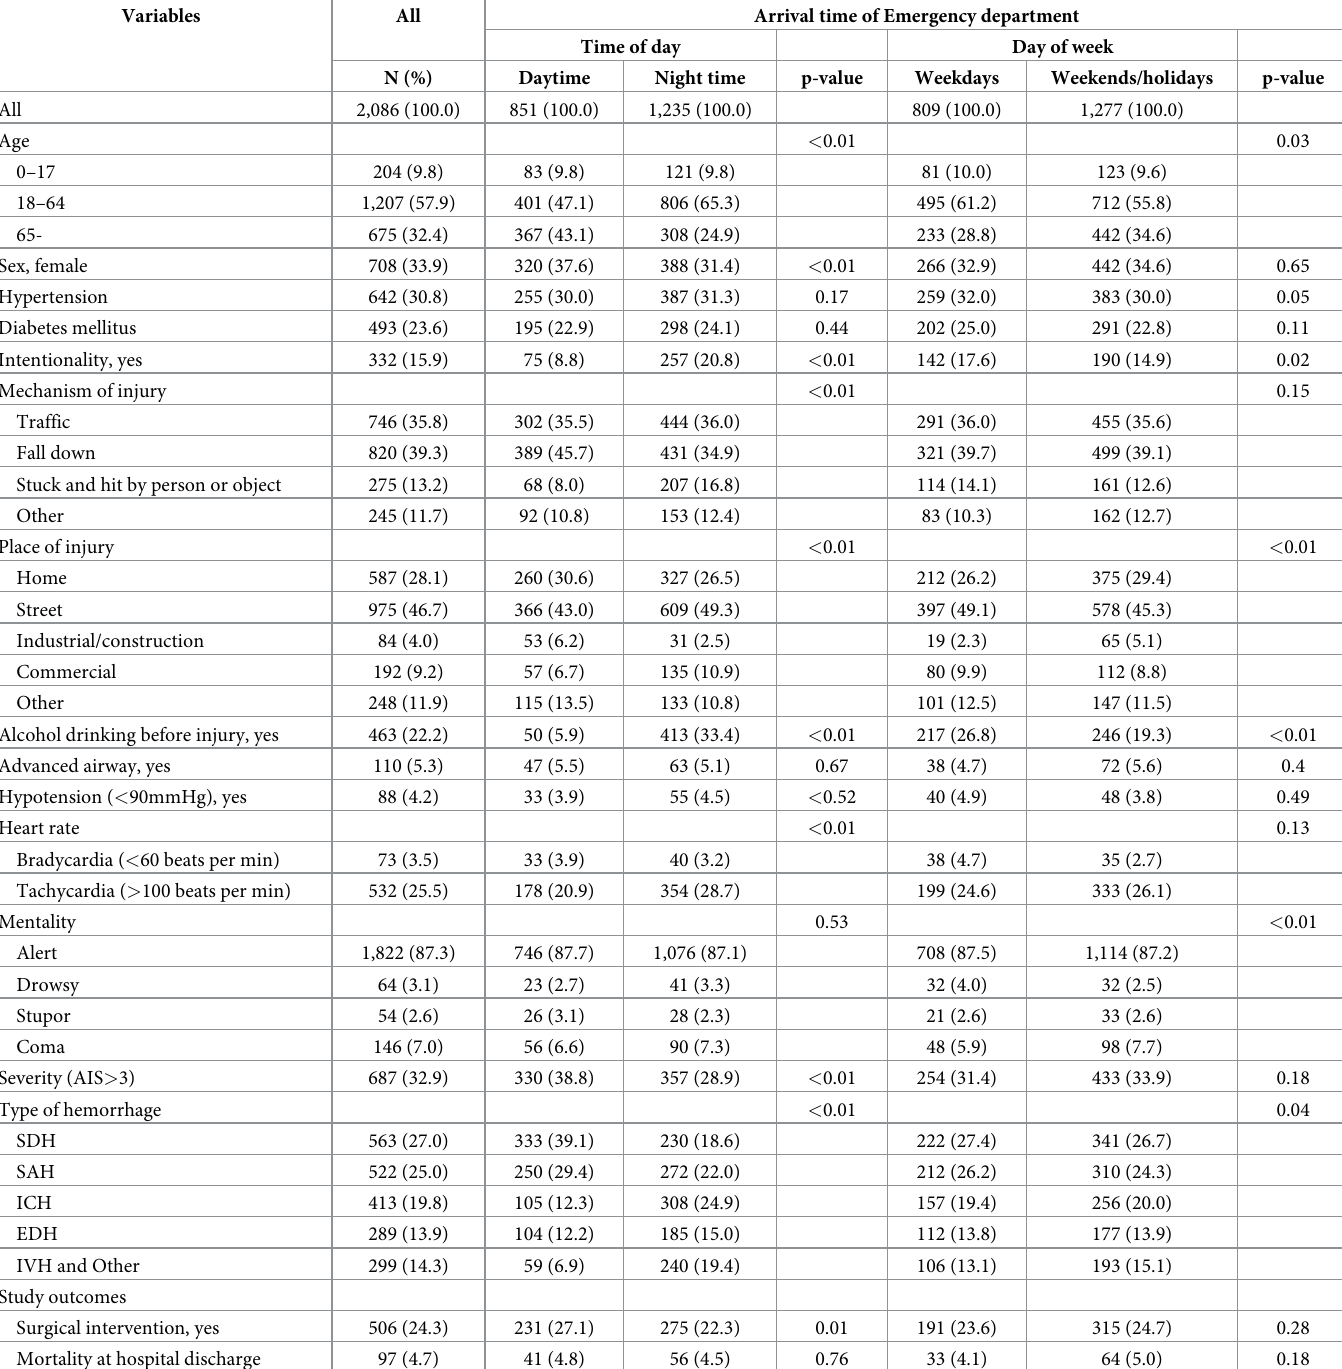
Table 1. Characteristics of the study population according to the arrival time (Time of day and Day of week) of emergency department.